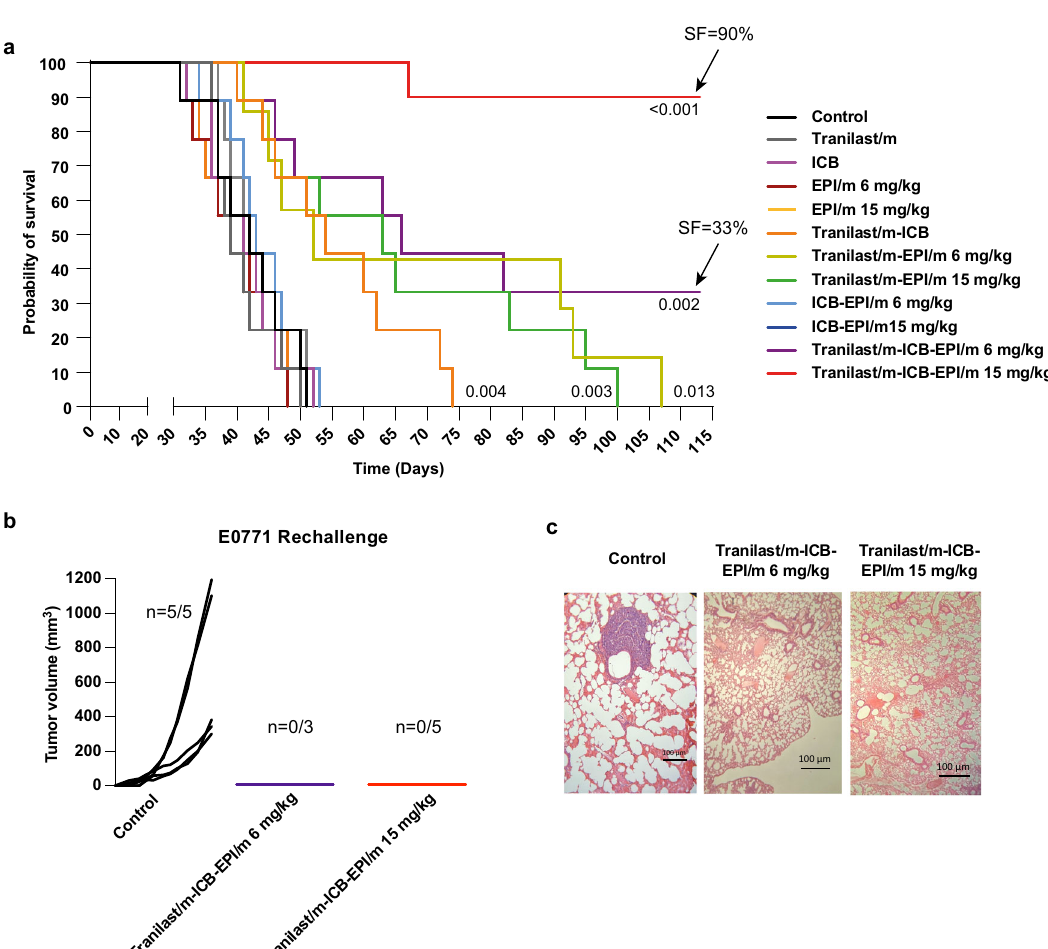
Fig. 6 | Tranilast-epirubicin micellar combination increases overall survival, potentiating immunological memory. a Kaplan – Meier survival curves for the various treatments considered ( n =10 mice). Arrows indicate the survival fraction (SF) of mice at day 113. Statistical analysis was performed by a log-rank (Mentel- Cox)testcomparingthetreatedgroupswiththecontrol. b Individualtumorgrowth